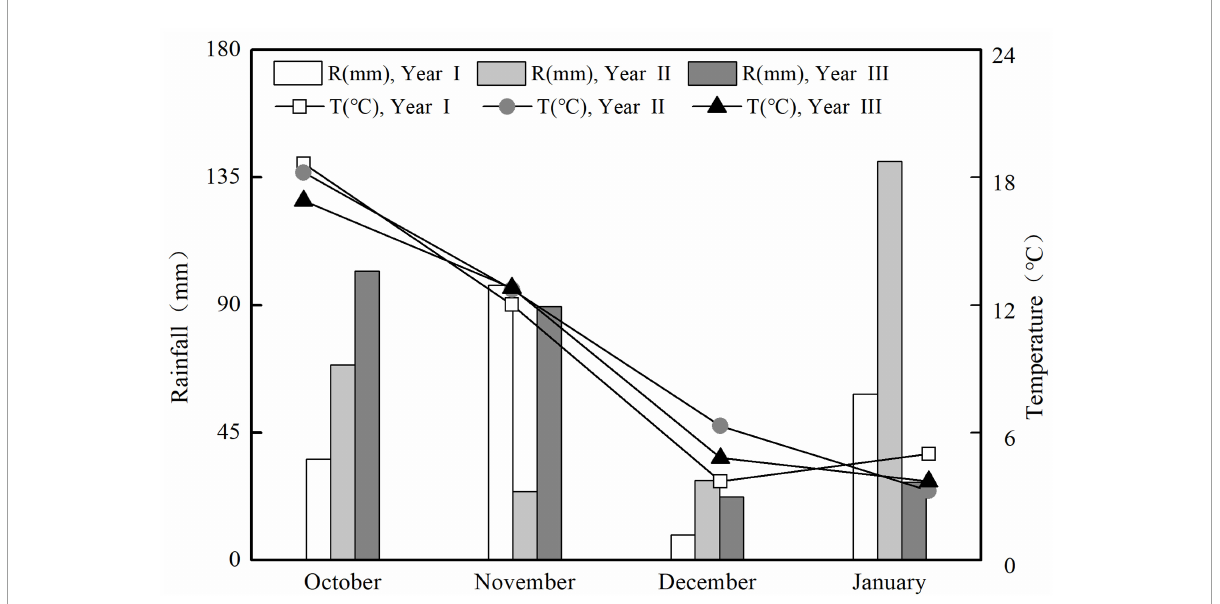
FIGURE1 Monthly precipitation (R, mm) and average air temperature ( T , ◦ C) at the experiment site in cropping Years I, II, and III.